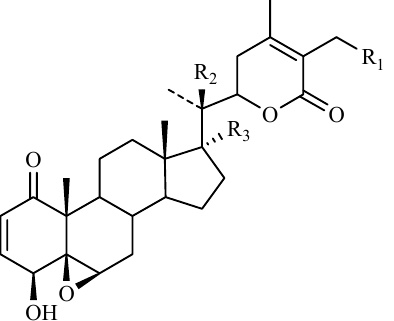
Figure 4. Different structures of